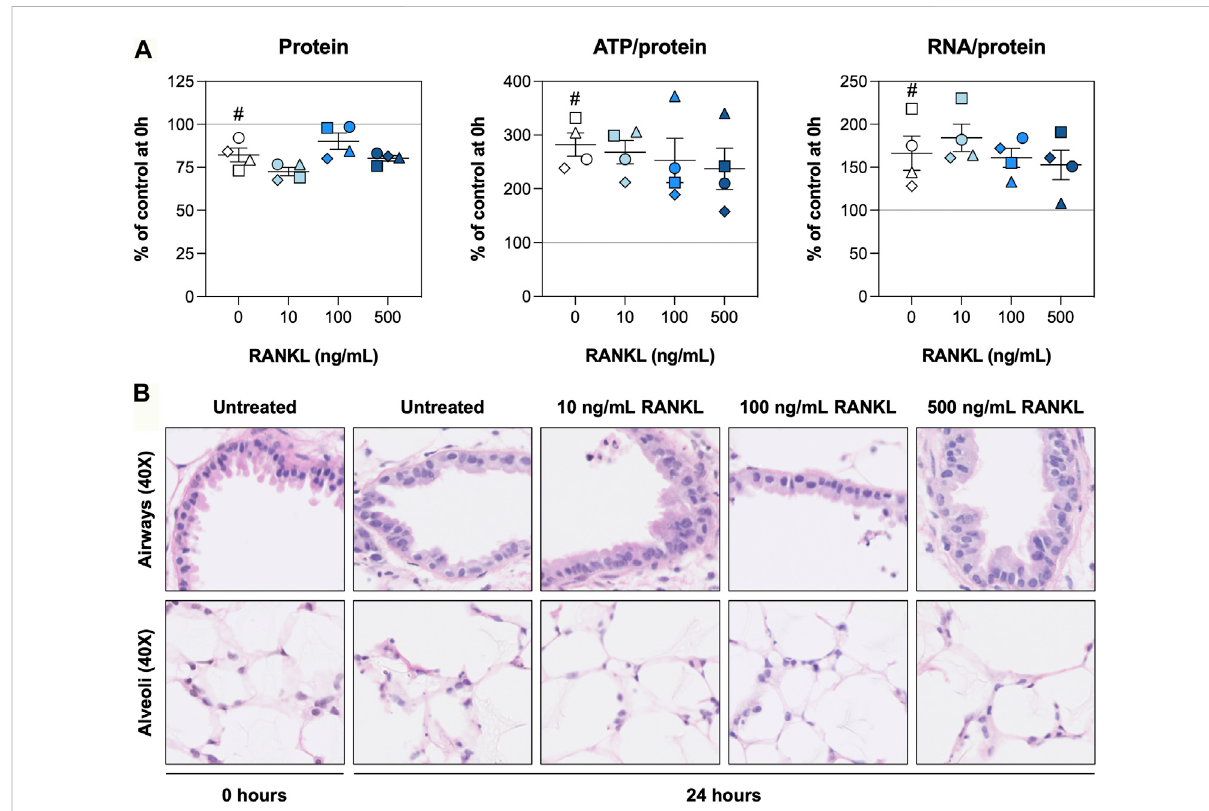
FIGURE 1 Slice viability and morphology. Slices were sampled after slicing (0 h) and after 24 h of incubation without or with 10, 100, or 500 ng/ml RANKL ( n =4).Theprotein,ATP/protein,andRNA/proteincontent (A) wasdeterminedtoassessgeneralsliceviability,andH&Estainings (B) werecarriedout to visualize the morphology. Values represent individual experiments performed in triplicate and are accompanied with the arithmetic mean (horizontal line) ± standard error of the mean (error bars). ( # indicates p < 0.05 between untreated slices at 0 and 24